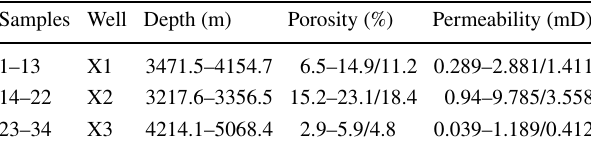
Table 1 Sample basic parameters